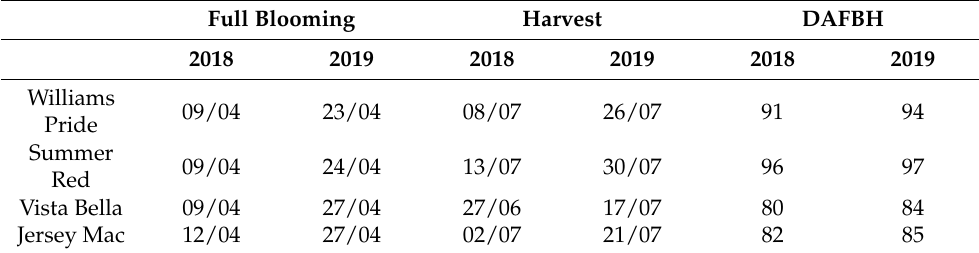
Table 1. Phenological characteristics’ times of cultivars according to